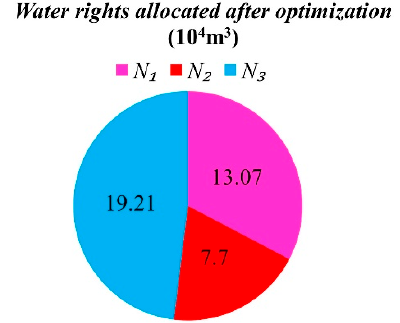
Figure 3. Initial allocation of water rights.